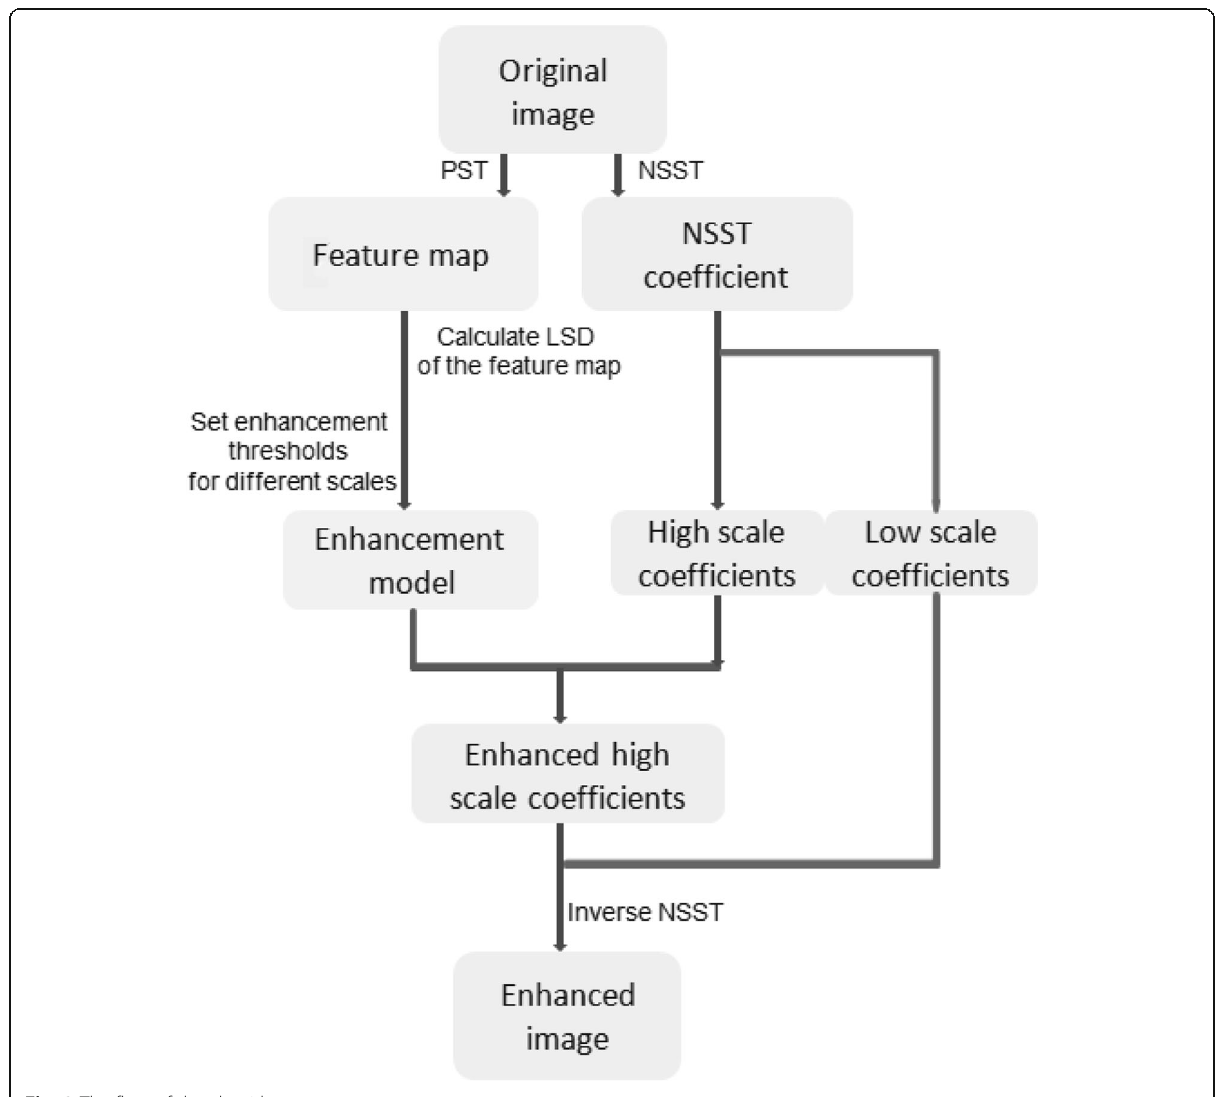
Fig. 3 The flow of the